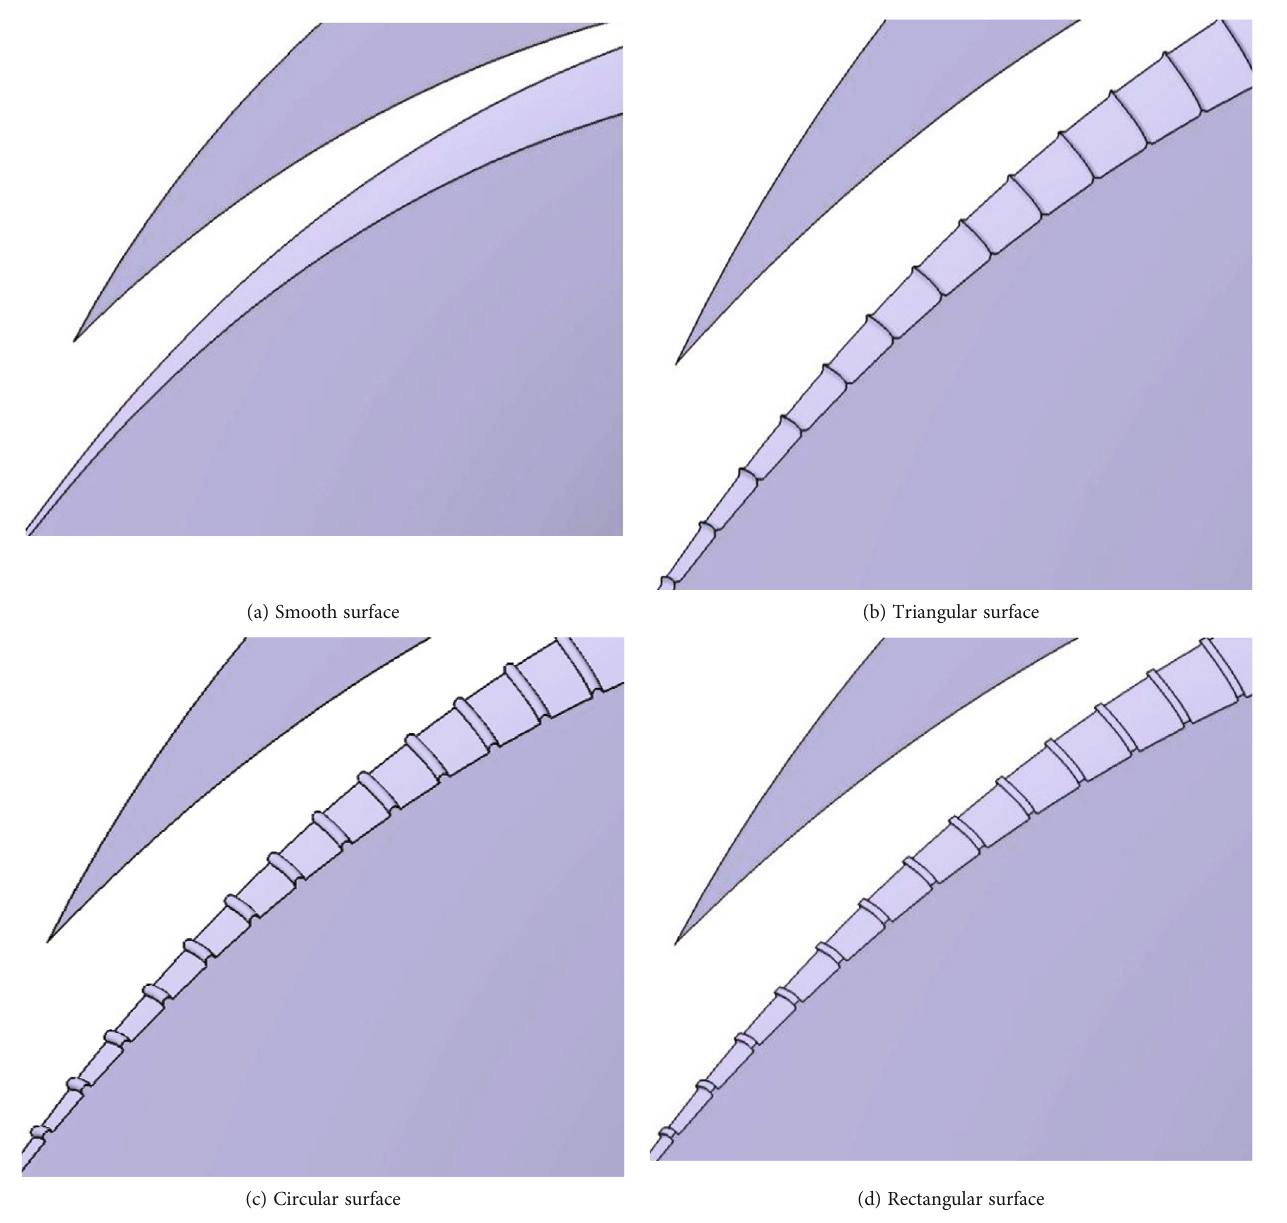
Figure 4: Impeller fl uid domain with four di ff erent surface structures. Table 1: Mesh independence analysis